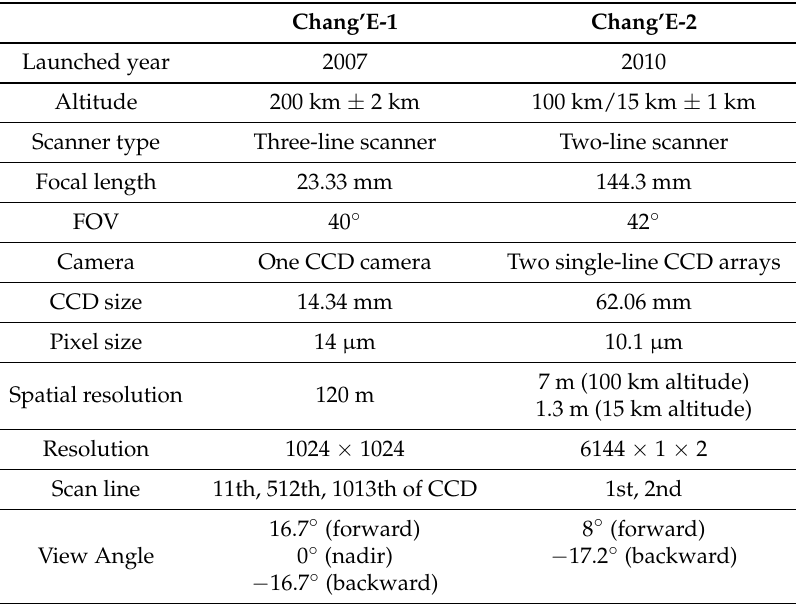
Table 1. The specifications of push broom scanners on Chang’E-1 and